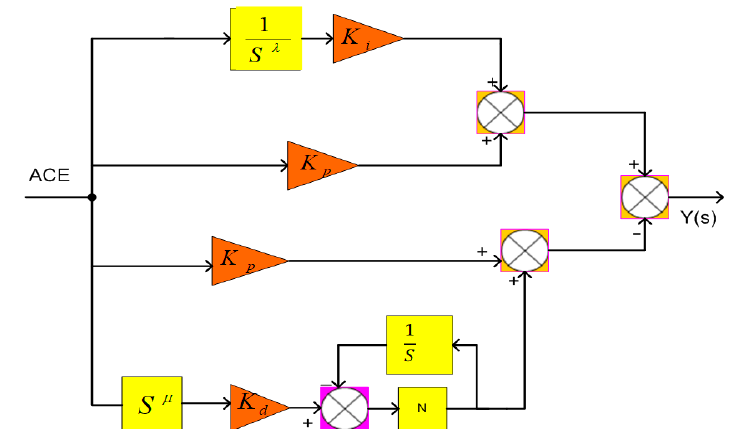
Figure 6. Design of FOPI-PDF controller.